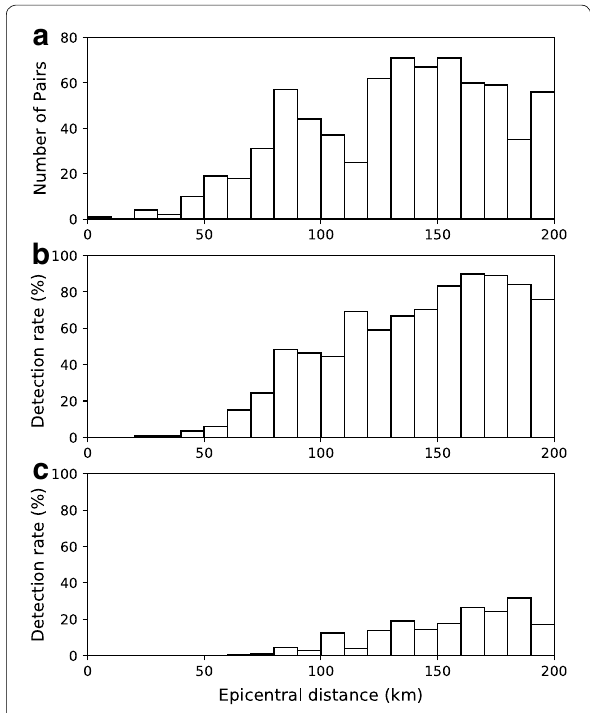
Fig. 7 a Histogram of the number of detected tremor pairs by epicentral distance. b Histogram of the detection rate for synthetic waveforms of two sources via the proposed location method by epicentral distance. c Histogram of the detection rate for synthetic waveforms of two sources via the location method with no weighting